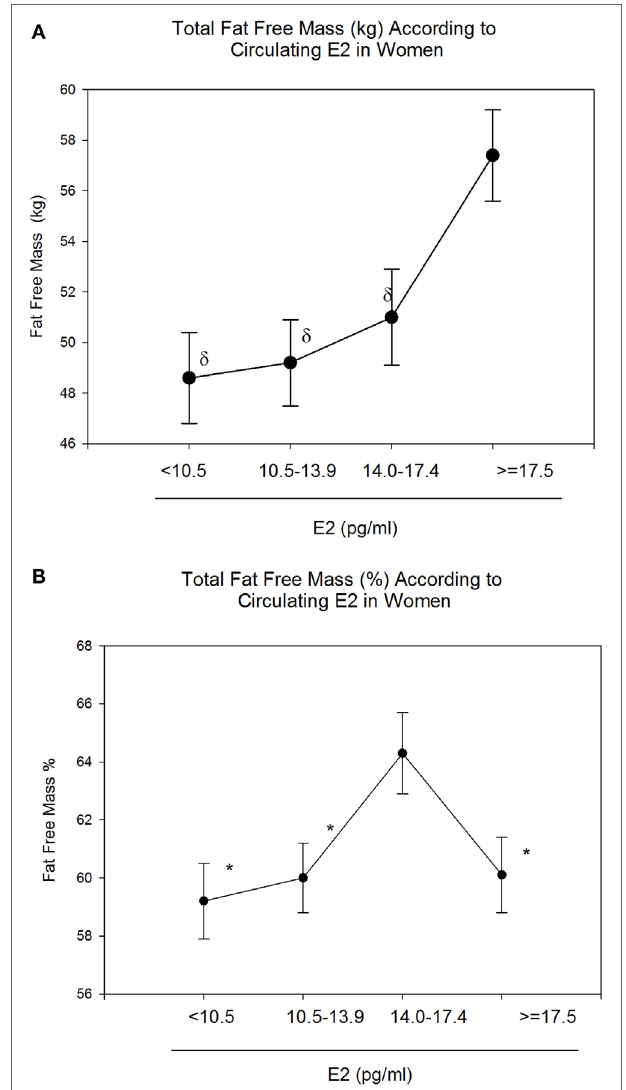
FigUre 1 | Total fat mass (FM) (kg and %) according to estradiol (E2) categories. E2 levels between 14.0 and 17.4 pg/ml correspond to the lowest total FM [kg–%, (a,B) ]. Data are reported as mean ± SE. *Comparison with group 3 (E2: 14.0–17.4), p <